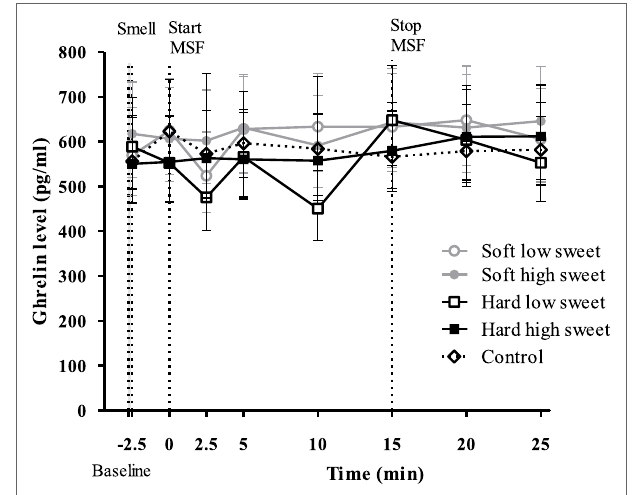
FigUre 7 | Geometric mean ± 95% CI ghrelin (pg/ml) concentrations corrected for baseline concentration per treatment and control condition. No significant differences were found between treatments and control condition at any time point ( p = 0.63).